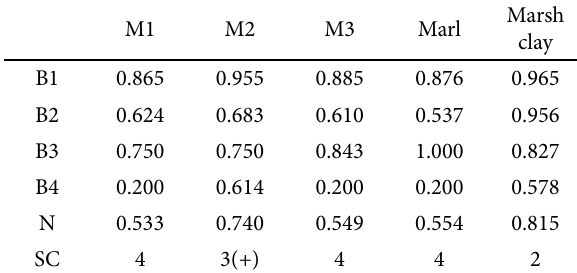
Table 16. Evaluation numbers N and suitability classes